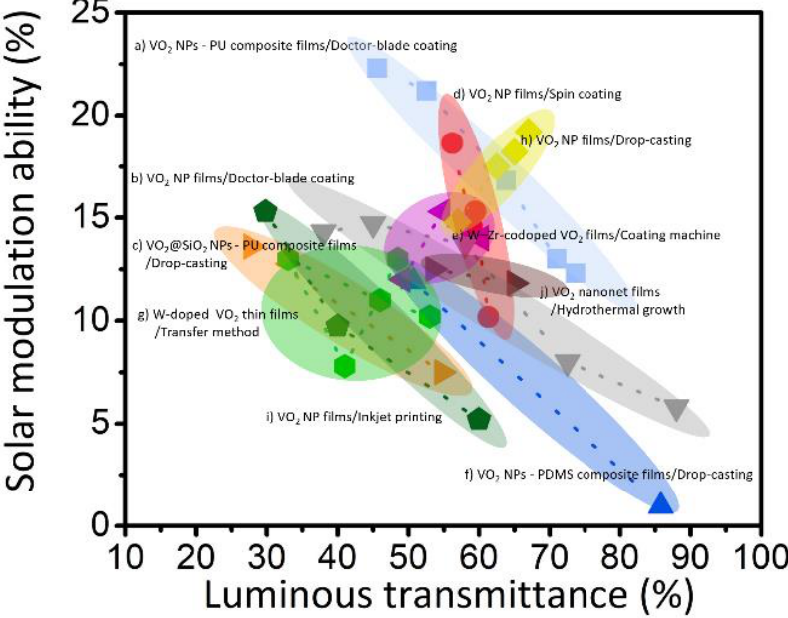
Figure 13. Comparison of luminous transmittance (T lum ) and solar modulation ability (ΔT sol ) be- tween flexible VO 2 thin films fabricated via hydrothermal reaction: (a) [80] , (b) [139] , (c) [56] , (d) [136] , (e) [118] , (f) [149] , (g) [74] , (h), [64] , (i) [143] , (j) [109] .